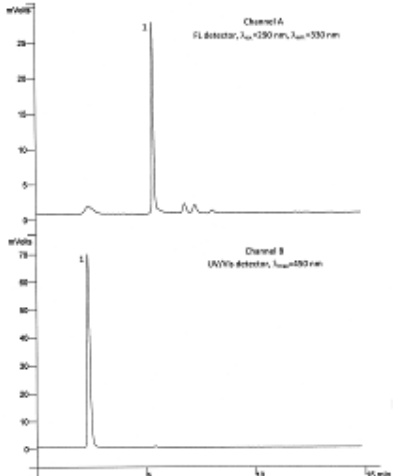
Fig. 1: Chromatogram of standard tocopherols (2.00 μg mL -1 of each) and b -carotene (0.80 μg mL -1 ). Channel A: 1= a -tocopherol, 2= b -toco- pherol, 3= g -tocopherol, 4= d -tocopherol. Channel B: 1= b -carote-